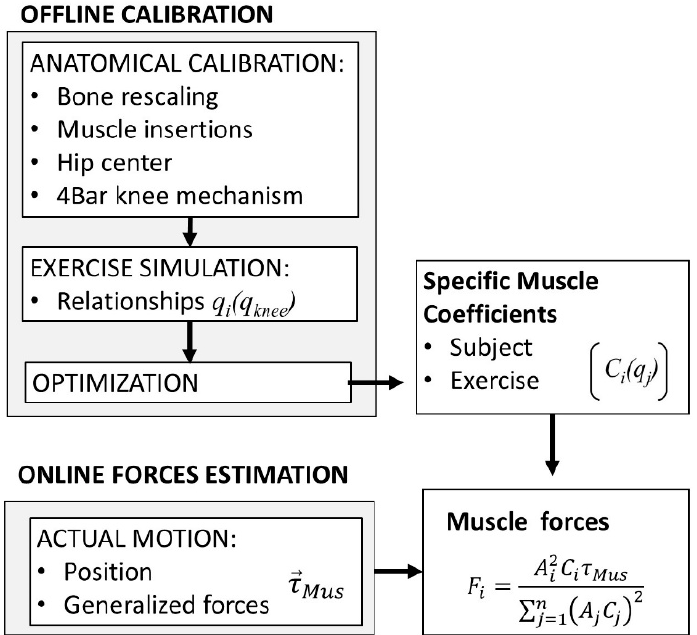
Figure 2. Application of the model.